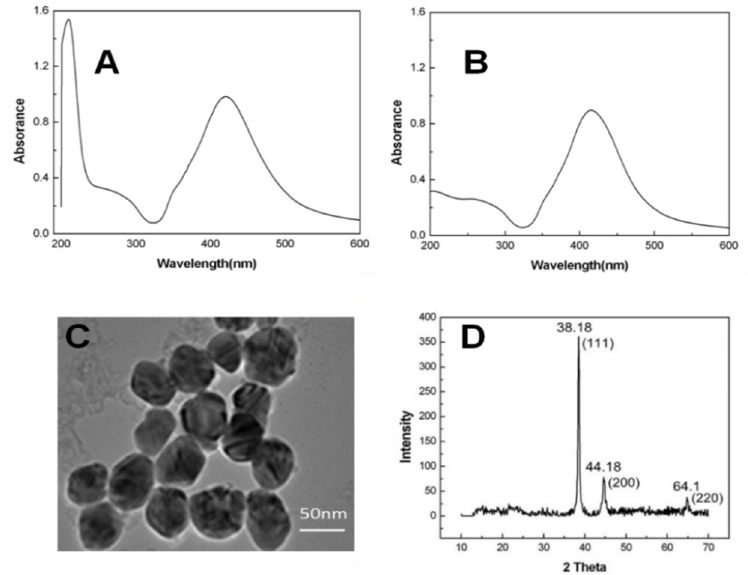
Figure 1. ( A ) UV-vis absorption spectra of freshly prepared AgNPs; ( B ) UV-vis absorption spectra of AgNPs after centrifugation; ( C ) Transmission electron microscope (TEM) image of prepared AgNPs; ( D ) XRD diagram of prepared AgNPs. The average dimensions of the AgNPs were decided by counting 60 NPs for each sample.